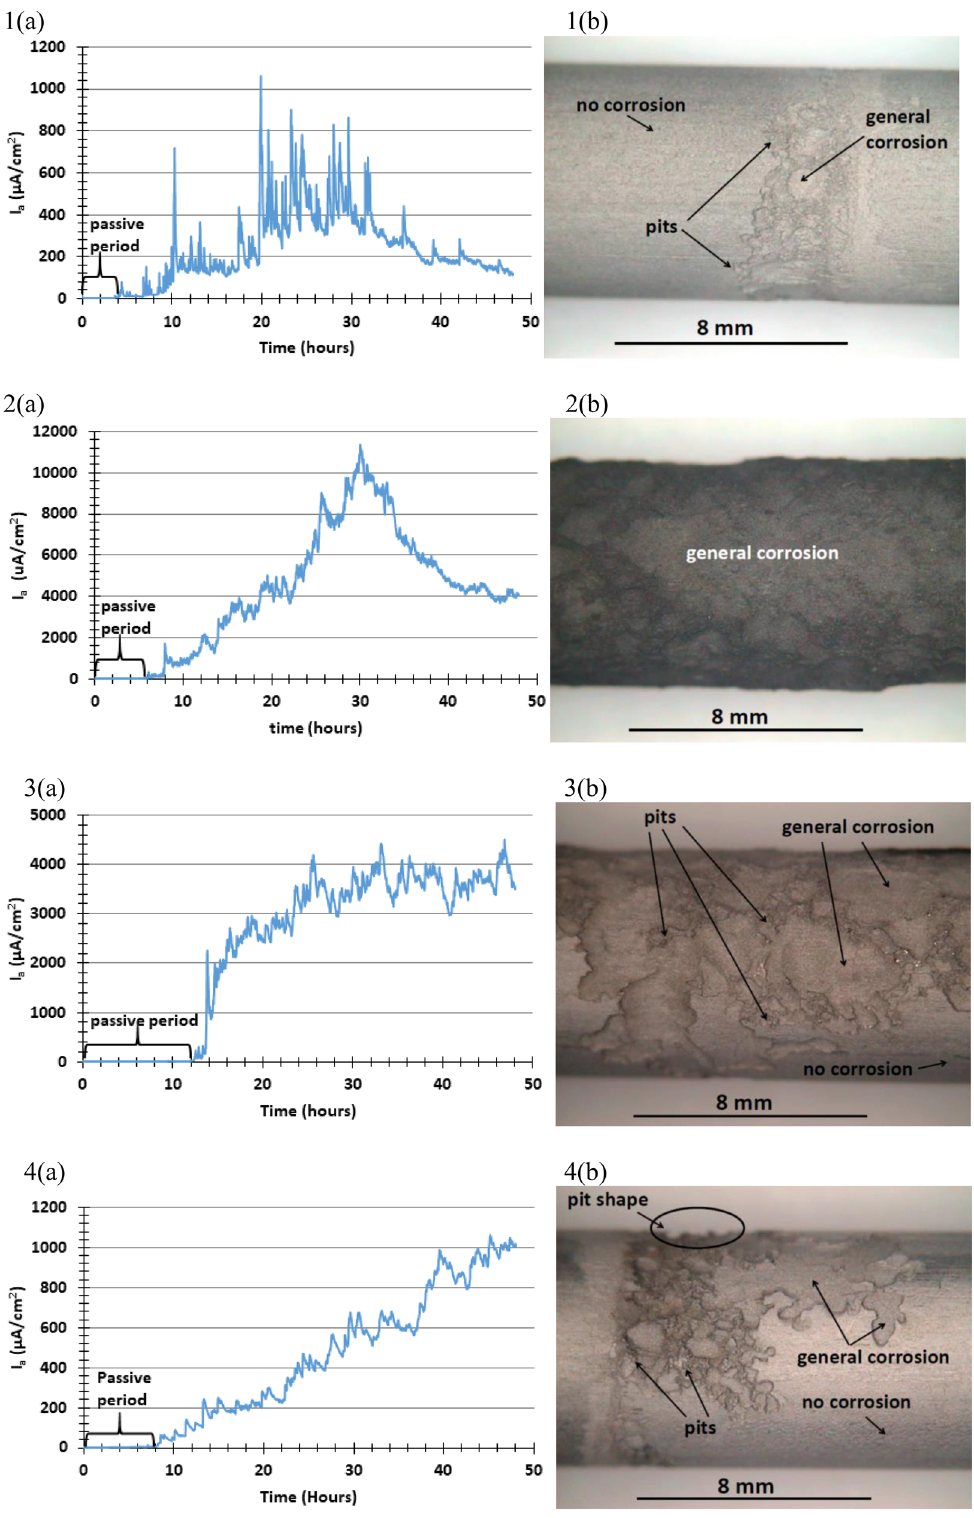
Figure 9: I a of HSHCsw during 48 h in deaerated electrolyte at pH 13.4 and its corresponding surface morphology ( light microscope: 15 ×) at: ( 1a and 1b ) 0.1 M Cl − and + 100 mV, ( 2a and 2b ) 0.25 M Cl − and + 0 mV, ( 3a and 3b ) 0.5 M Cl − and − 200 mV, and ( 4a and 4b ) 1 M Cl − and − 350 mV, corresponding to the points plotted on the curve in Figure